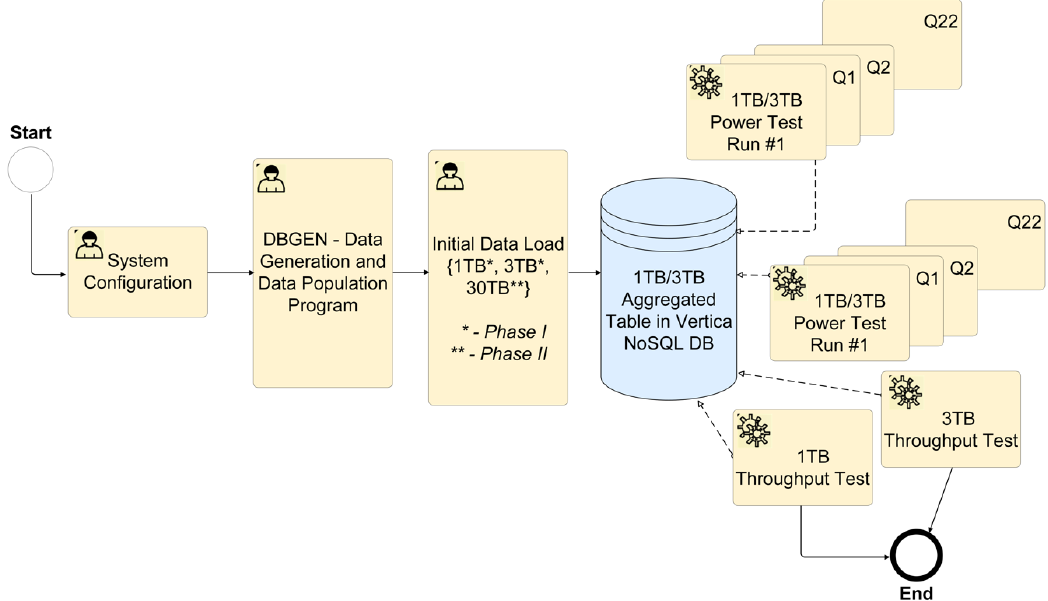
Figure 1. Testing activity diagram for the data warehouse eSystem configuration.